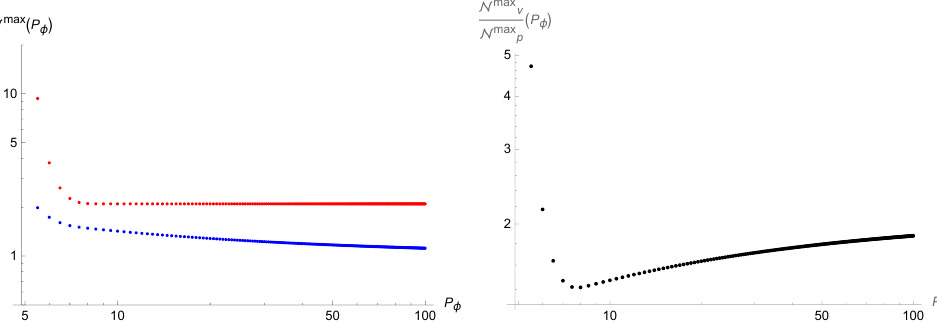
Figure 3. ( Left ): number of final particles as function of the initial condition P φ ; blue and red dots refer respectively to the Ashtekar variables and the volume variables. ( Right ): ratio between the numbers of final particles in the two